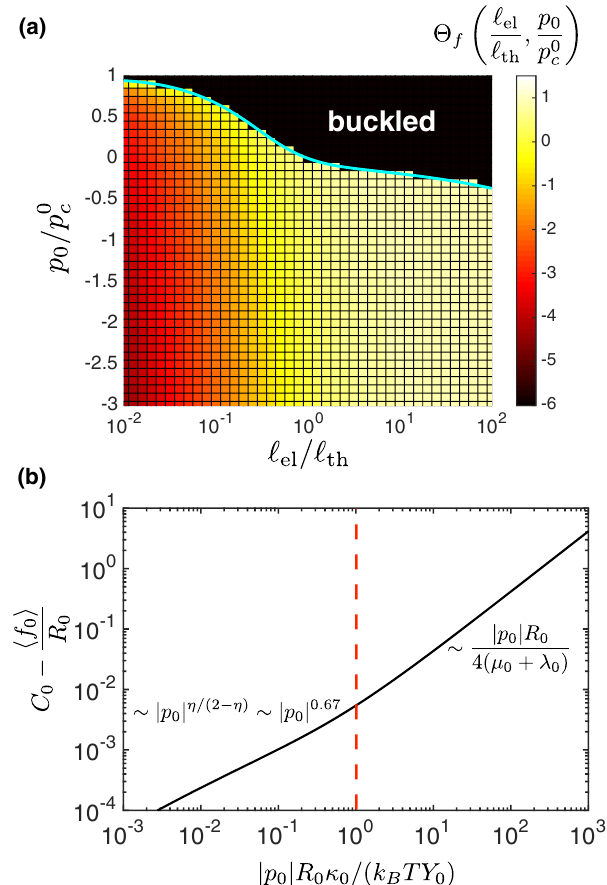
FIG. 4. Heat map depicting the average thermal shrinking of the shell radius h f 0 i , as described by the scaling function l Θ = l ; p 0 =p 0 [see Eq. (31)]. (a) Contours of the scaling f ð c Þ el th 10 2 and a=R 10 − 6 . The are shown with R 0 = l function Θ 0 ¼ f el ¼ solid cyan line corresponds to the critical buckling pressure in Eqs. (34) and (35) displayed as the solid black curve in Fig. 5. ≪ l (b) Nonlinear response for large membranes ( l ) under th el large outward pressure p 0 < 0 [see Eq. (32)]. Here, the parameter T= ð 8 πκ 0 Þ½ ln ð l =a Þ þ 1 = η (cid:3) , whereas on the y axis C 0 ≈ k B th l 10 1 , R l 10 3 , and a=R 10 − 6 = l 0 = 0 ¼ el th ¼ el ¼